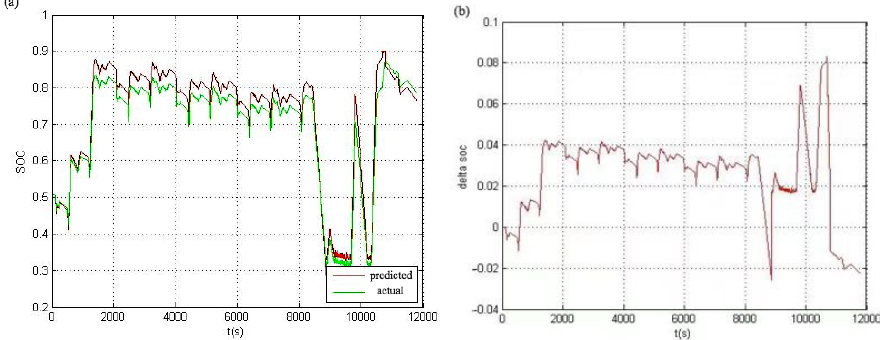
Figure 13. Comparison chart of ( a ) predicted terminal voltage and actual value; ( b ) the difference through NEDC cycle test.